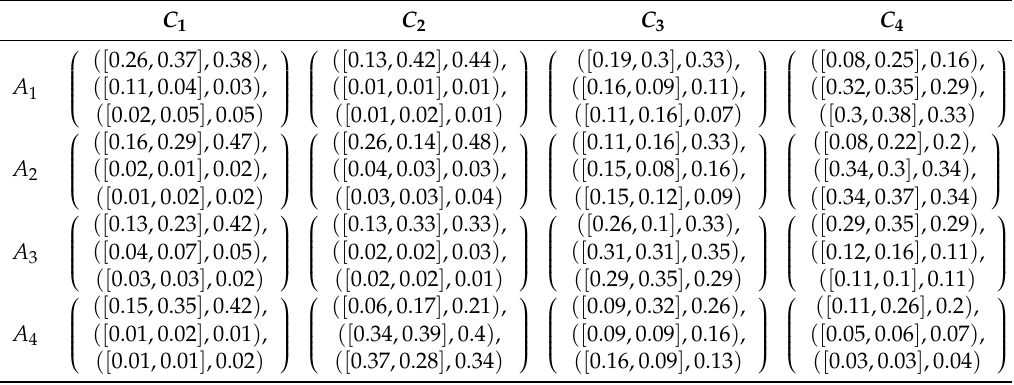
Table 6. Aggregation of all decision-maker data by the spherical cubic fuzzy Hamacher ordered weighted geometric (SCFHOWG) operator. C 1 C 2 C